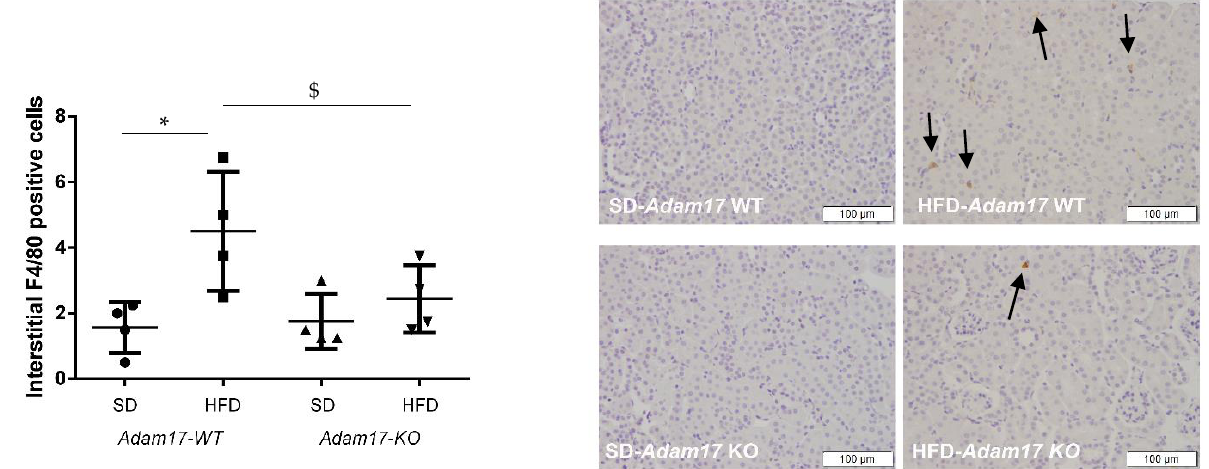
Figure 3. Influences of HFD and endothelial Adam17 deletion on renal macrophage infiltration. Quantification and representative cortical images of F4/80 immunostaining ( n = 4). Black arrows showed positive F4/80 cells. 200 × magnification, scale bar 100 µ m. Data are expressed as mean ± SD.